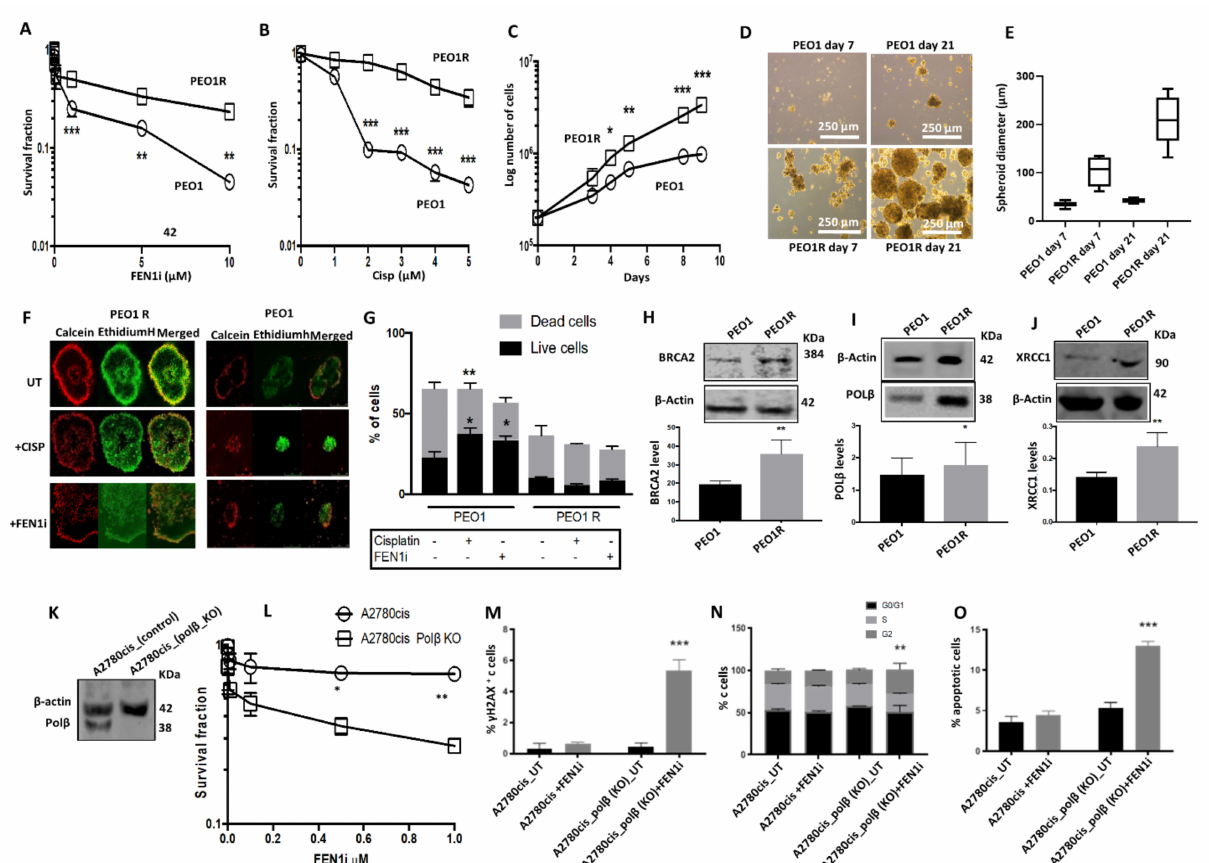
Figure 6. ( A ) Clonogenic assay showing FEN1 inhibitor sensitivity in PEO1 and PEO1R cells. ( B ) Clonogenic assay showing cisplatin sensitivity in PEO1 and PEO1R cells. ( C ) Growth curves showing an increased proliferation rate in PEO1R cells compared to PEO1 cells. ( D ) Representative photomicrographs showing enhanced spheroid formability of PEO1R cells compared to PEO1 cells. ( E ). Quantification of spheroid diameter in PEO1 and PEO1R on day 7 and day 21. A total of 50 spheroids were evaluated for spheroid diameter in PEO1 and PEO1R on day 7 and day 21. ( F ) FEN1 inhibitor sensitivity in PEO1 and PEO1R spheroids. ( G ) Quantification of dead and living cells in FEN1 inhibitor-treated PEO1 and PEO1R spheroids. ( H ) Western blot showing BRCA2 expression in PEO1 and PEO1R cells. ( I ) Western blot showing pol β expression in PEO1 and PEO1R cells. ( J ) Western blot showing XRCC1 expression in PEO1 and PEO1R cells. ( K ) Western blot showing pol β _Knockout (KO) in A2780cis cells using CRISPR methodology [First incubation was